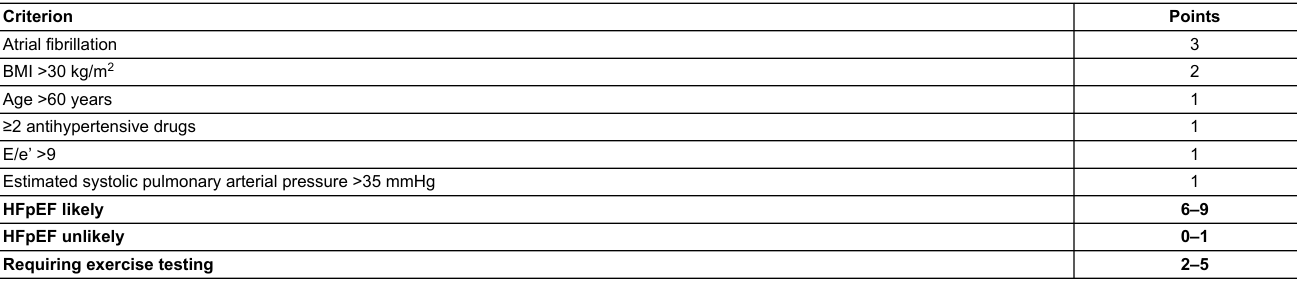
Table 2: Score to non-invasively pre-screen patients with exertional dyspnea as proposed by Reddy et al. [38]